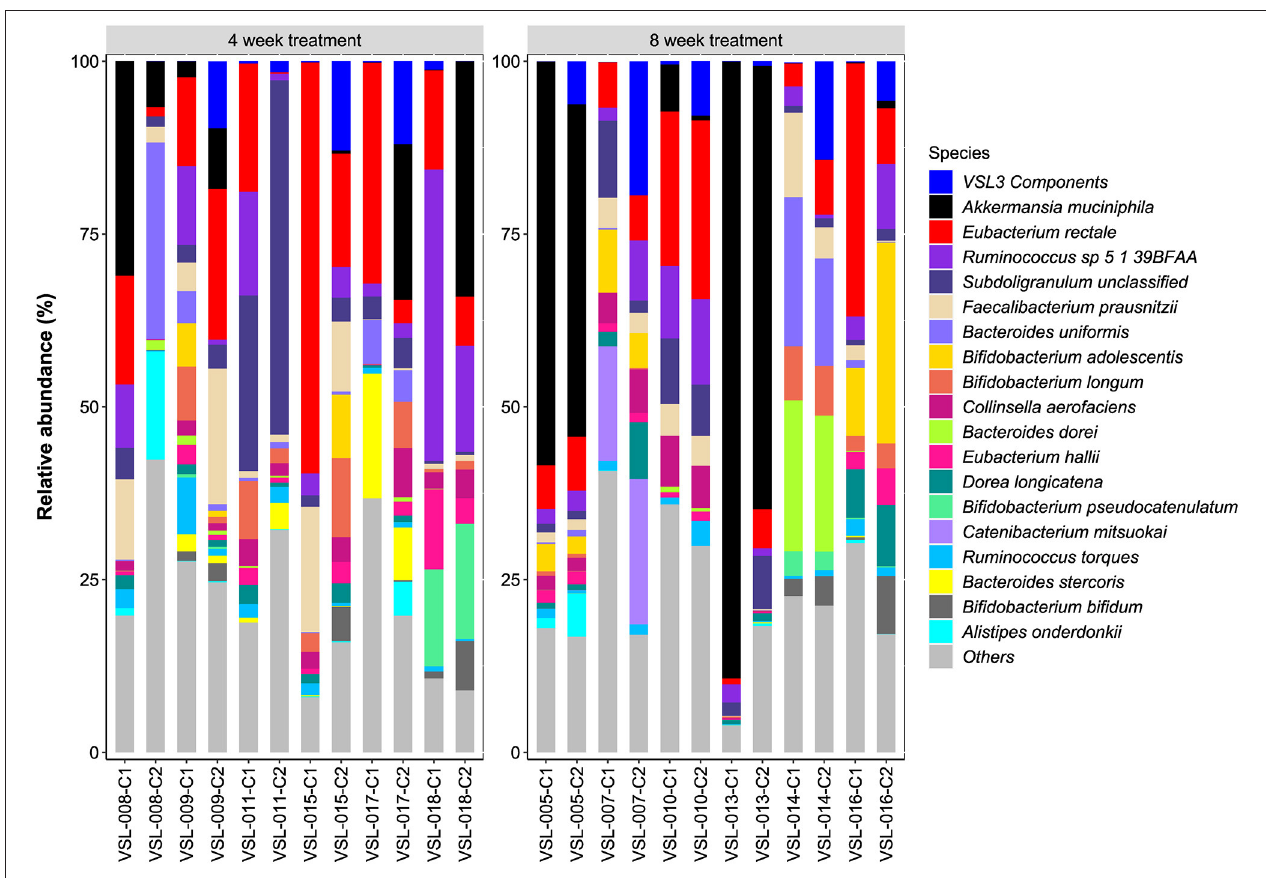
FIGURE 3 | Species-level relative abundances of community members after both 4- and 8-weeks of